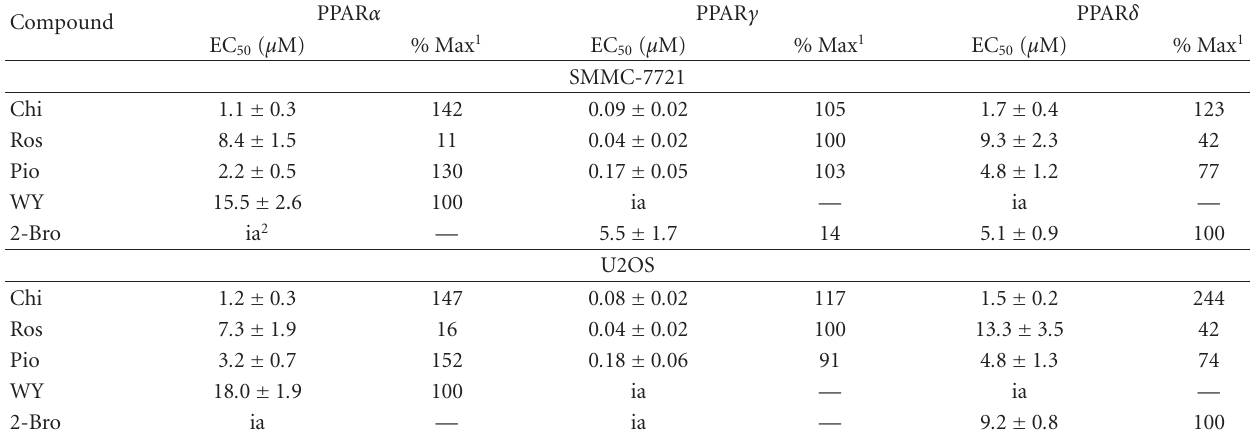
Table 2: In vitro transactivation activity of chiglitazar in di ff erent PPAR subtypes.